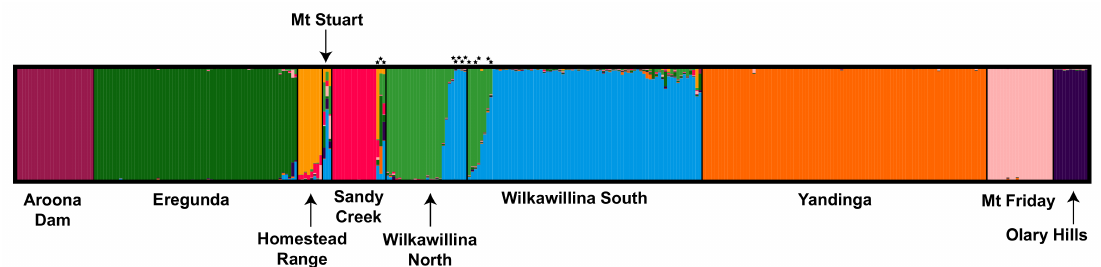
Figure 2. STRUCTURE plot outlining the proportional membership (Q) of each P. x. xanthopus individual (represented by a single vertical bar) into genetic clusters. The populations are labelled and highlighted by black lines. Star (*) represents first generation migrants detected in GeneClass2 analyses (see Supplementary Tables S5 and S6 for